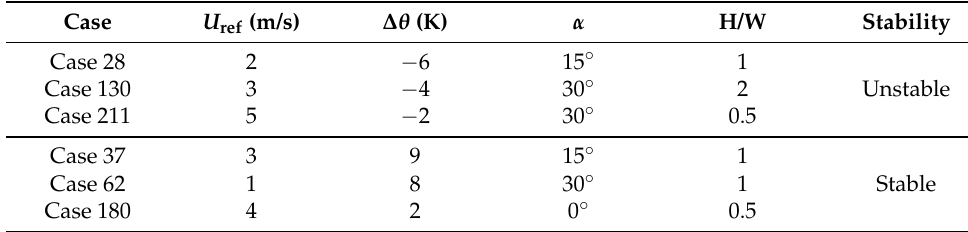
Table 8. Simulation inputs for sample